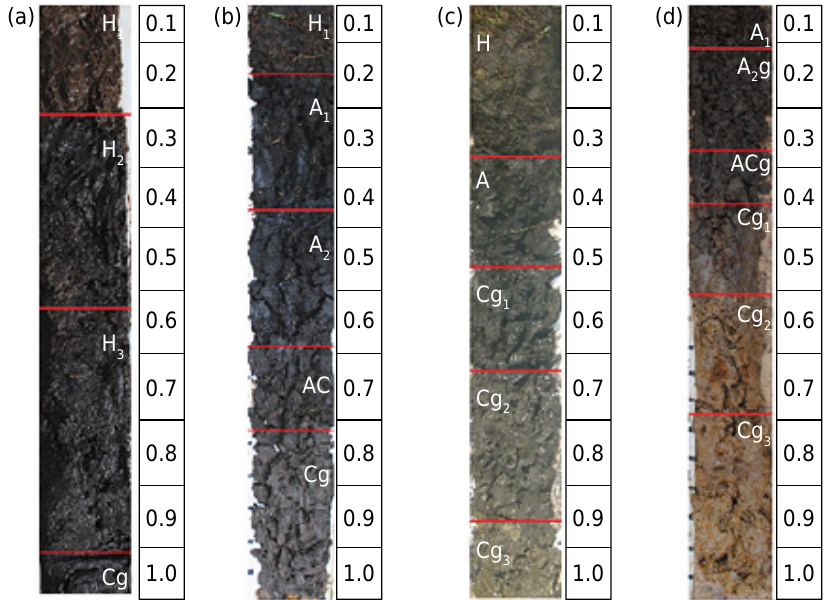
Figure 6. Digital photography of the soil monoliths classified as (a) Haplohemists - Organossolo Háplico Hêmico típico; (b) Endoaquents - Gleissolo Melânico Alítico organossólico ; (c) Endoaquents - Gleissolo Melânico Alítico organossólico ; and (d) Endoaquents - Gleissolo Melânico Alítico típico